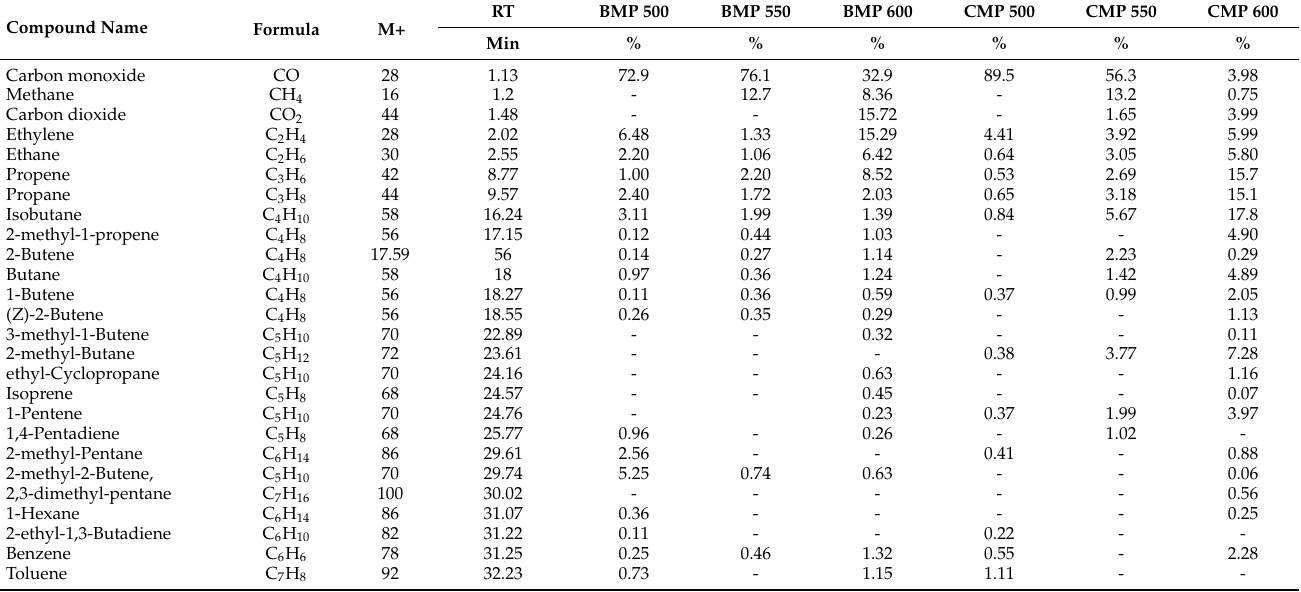
Table 8. Identified gas products of catalytic pyrolysis of BMP and CMP at 500,550 and 600 ◦ C. The units are percent compound of total collected